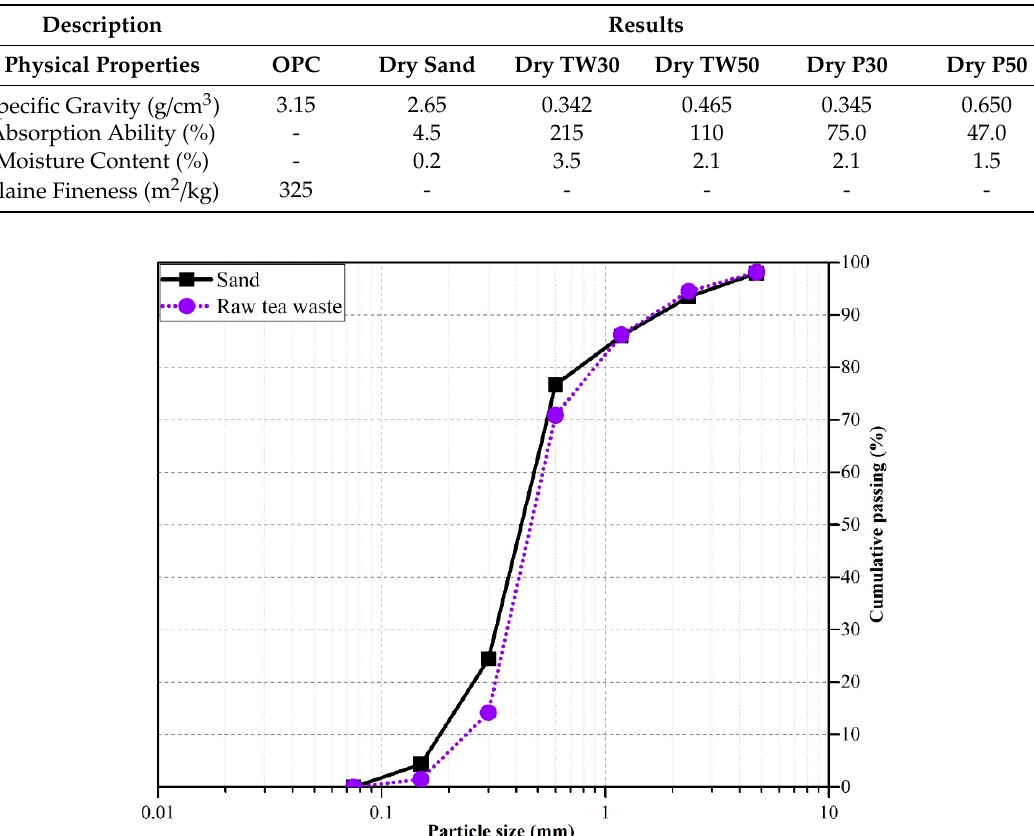
Table 2. Mix proportions of mortar specimens.